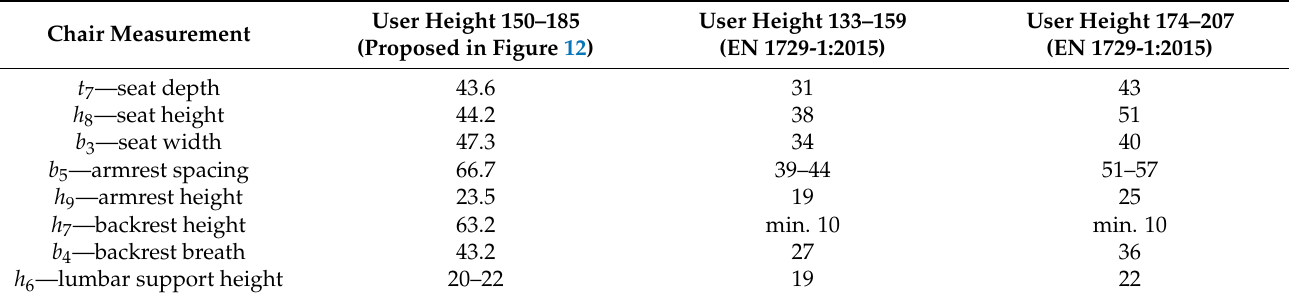
Table 3. Comparison of the proposed chair functional dimensions for the 5th–95th-percentile range of the adult population and functional dimensions according to the standard EN 1729-1:2015 [17] (in centimeters).